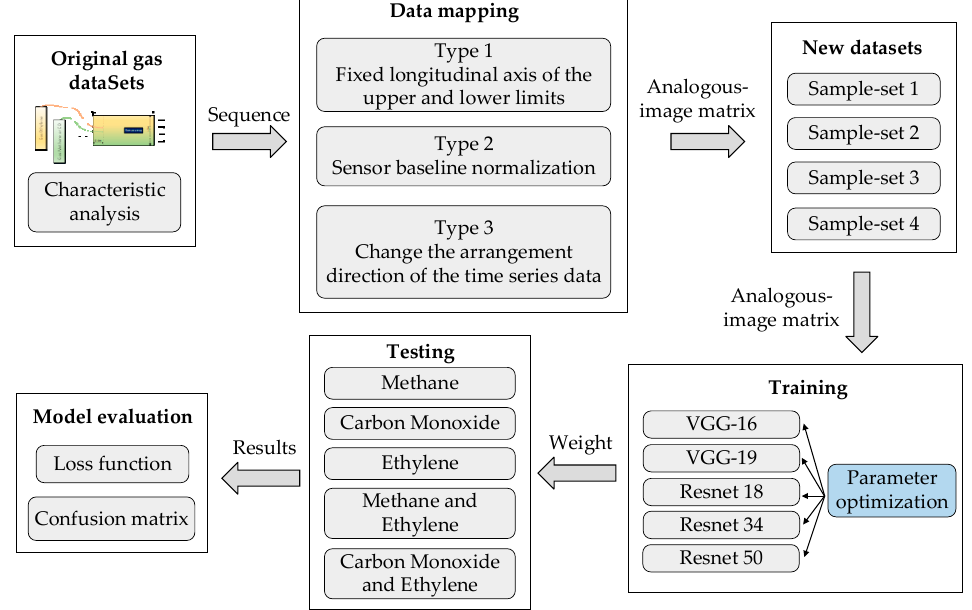
Figure 1. Overall processing procedure.